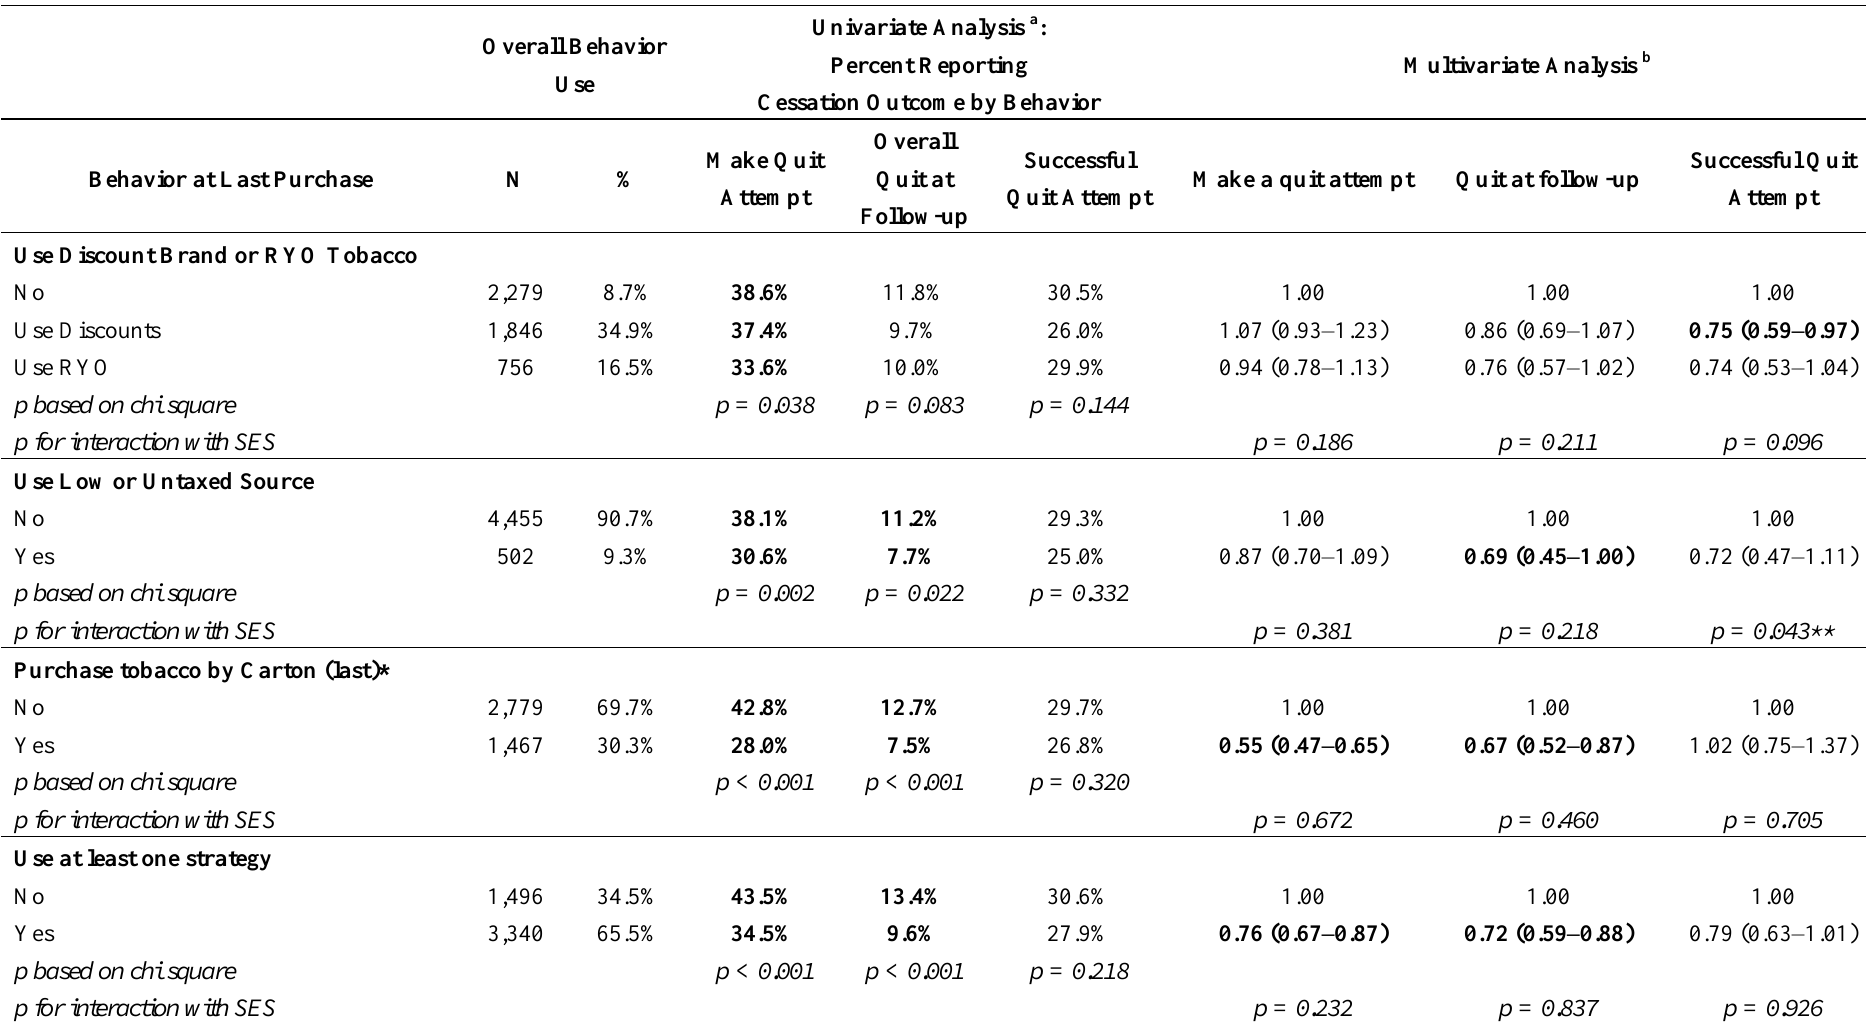
Table 3. Purchasing Behaviors at baseline as predictors of Cessation Outcomes at 1 year